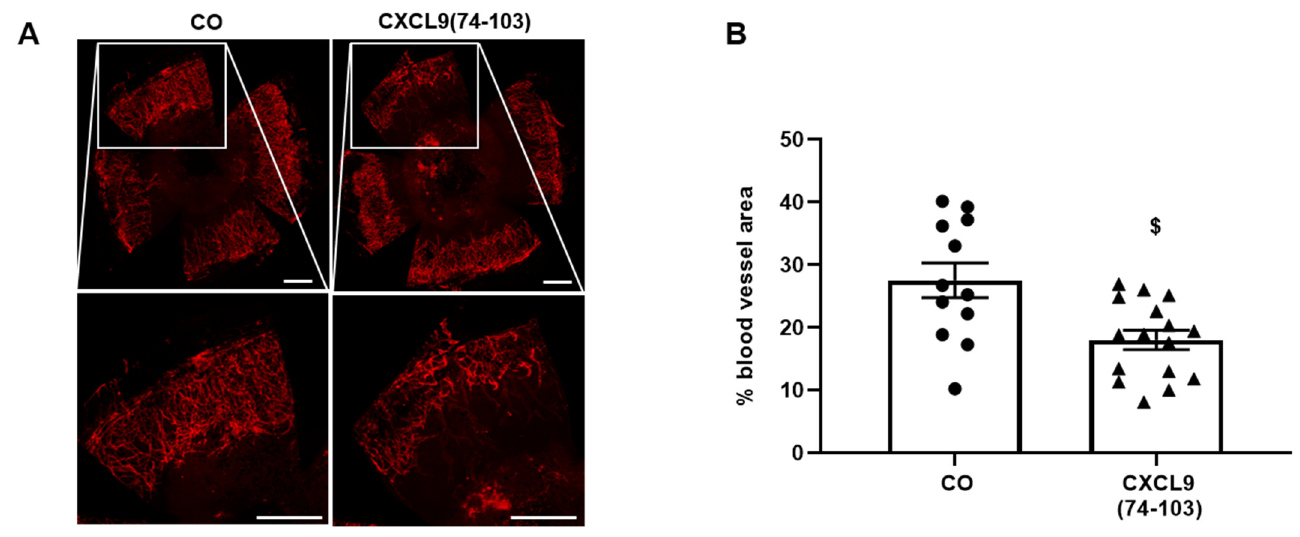
Figure 11. CXCL9(74-103) decreases pathological blood vessel outgrowth in response to thermal corneal injury. Mice were anesthetized and retinas were thermally cauterized on day 1. From day 2, the corneas were treated topically with drops of 100 µg/mL of CXCL9(74-103) or PBS for 4 days. On day 5 post-injury, corneas were excised and blood vessel outgrowth was visualized and quantified through fluorescent staining of CD31. ( A ) Representative images of thermal injury-induced corneal CD31 + blood vessels (red) and ( B ) quantification of CD31 + blood vessel area of PBS- and CXCL9(74-103)-treated corneas are shown. Scale bar = 500 µm. [mean (±SEM); Mann–Whitney U test; $ p < 0.05 (compared to PBS-treated corneas); (CO group: n = 12, CXCL9(74-103)-treated group: n = 16); the experiment was repeated three times].